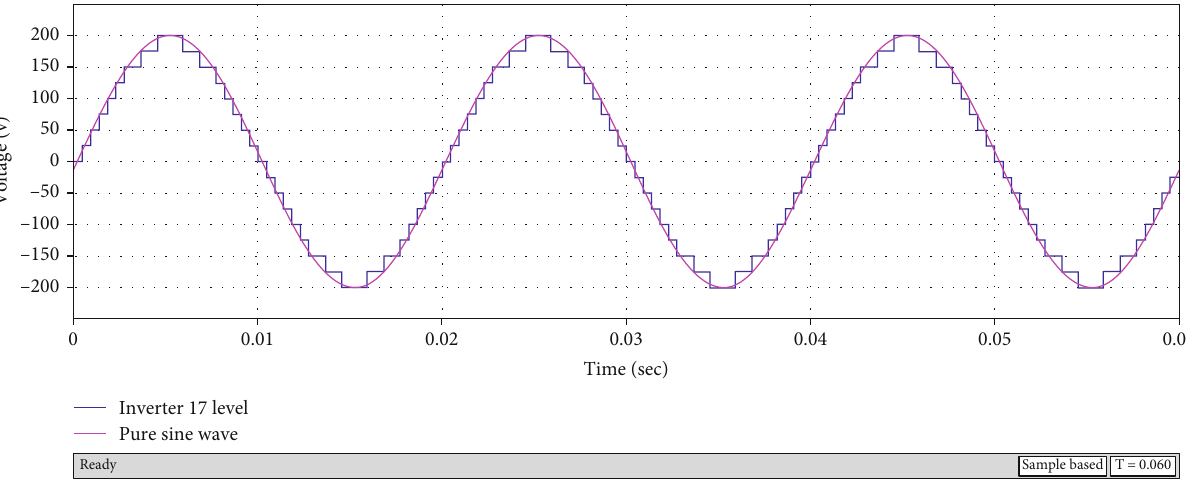
Figure 26: Single-phase 17-level MLI with t = 0 : 06